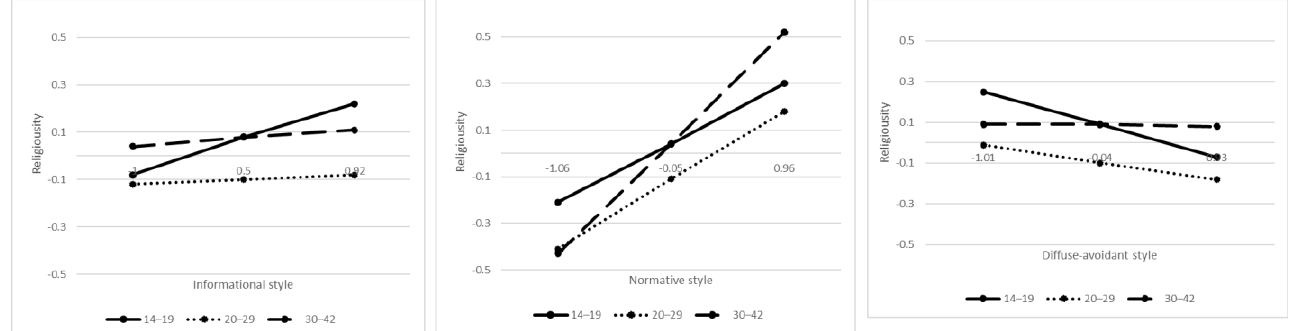
Figure 1. Effects of the explanatory variable (identity formation styles) on the dependent variable (overall level of religiosity) in each developmental period, as calculated using regression equations in 3 separate moderation analyses.